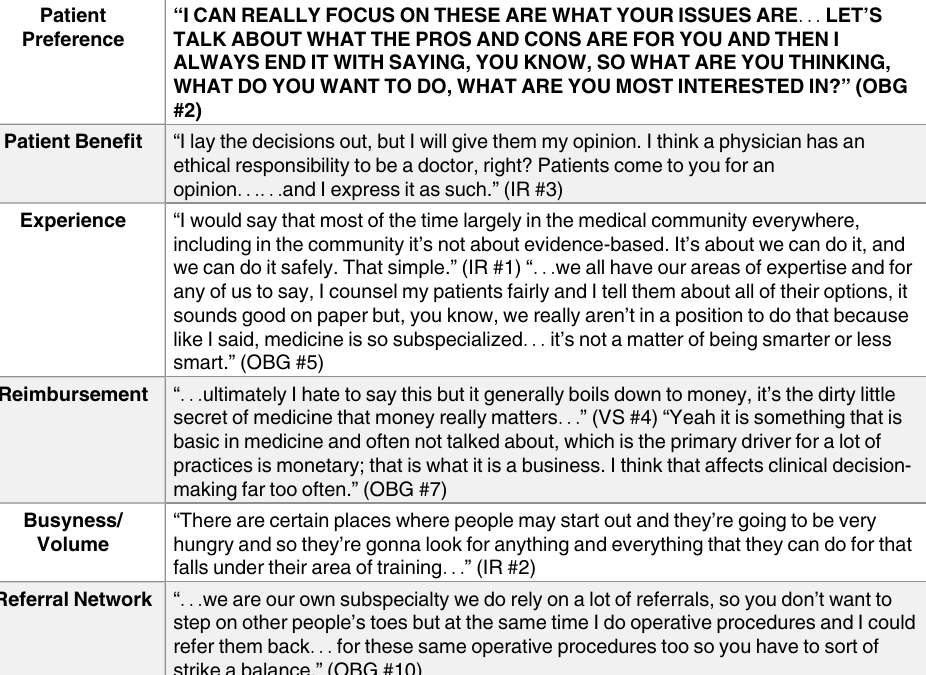
Table 3. Example quotes of physician